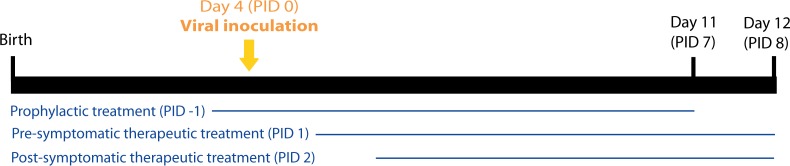
Experimental design.The thin horizontal lines represent the duration of the treatment with VHH. On PID 0, all groups were inoculated with 1778 DD50 of murine RVA (ECw). Prophylactic groups received the first daily doses of VHH on PID -1 and on PID 0, two hours before they were challenged with the viral inoculum. Pre-symptomatic and post-symptomatic treatments began on PID 1 and PID 2. Final euthanasia was performed at PID 7 for prophylactic groups and at PID 8 for therapeutic pre- and post-symptomatic groups. PID: Post Inoculation Day.